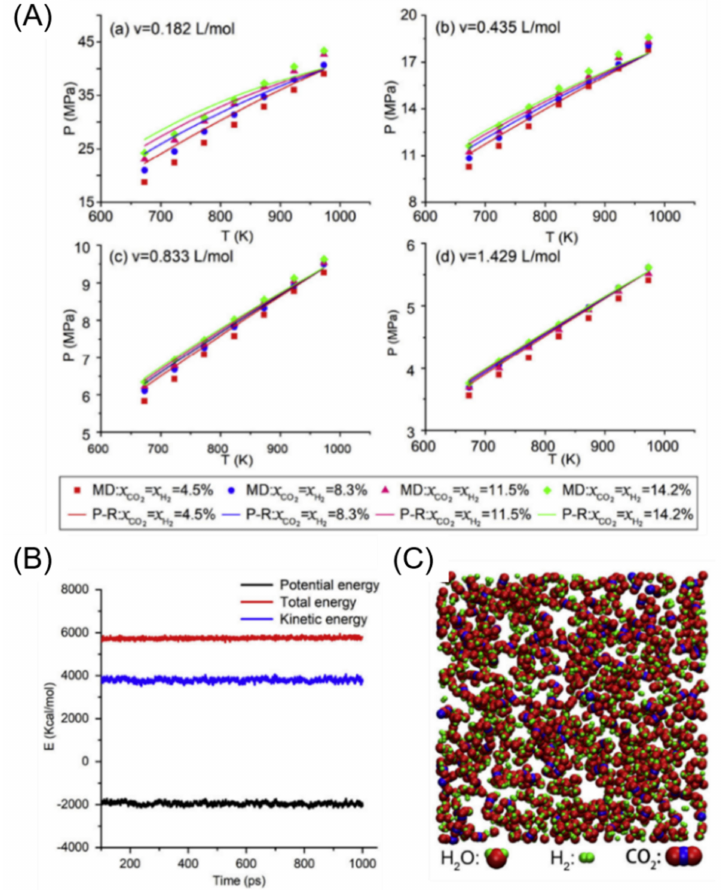
Figure 11. Representative data results from MD simulations on supercritical H 2 O/CO 2 /H 2 mixtures: ( A ) p ( T ) function compared with theoretical calculation for H 2 O/CO 2 /H 2 ternary mixtures at differ- ent molar volumes; ( B ) energies of systems at 673 (K) for mixtures with 1000 H 2 O, 200 CO 2 , and 200 H 2 molecules; ( C ) spatial distribution of molecules at end of simulations. (For in-depth interpretation of these data, readers are referred to the Yang et al. paper